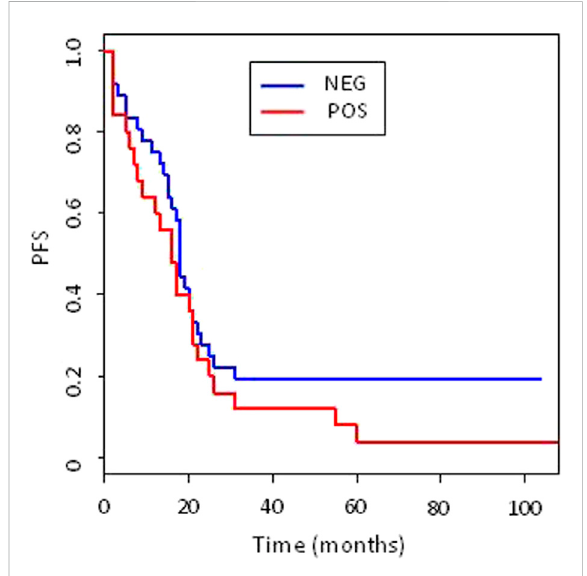
FIGURE 7 Kaplan Meier (KM) curves of Progression free survival (PFS). Patients were strati fi ed according to USP8 expression (blue lines negative, red line positive). KM curves compared with log-rank p